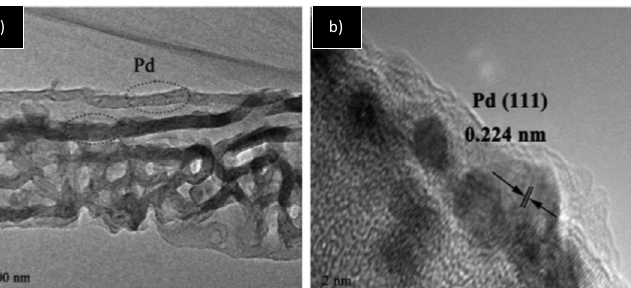
Figure 2. TEM images of the PdNPs on triazine-based-g-C 3 N 4 nanotubes (( a ) and ( b )). Inset in ( b ) shows crystallographic planes of fcc Pd(0) [24]. Reproduced from [24] with permission from Else- vier. Table 1. Comparison of the reported catalytic activity to the sequential condensation/reduction synthesis of α -alkylated